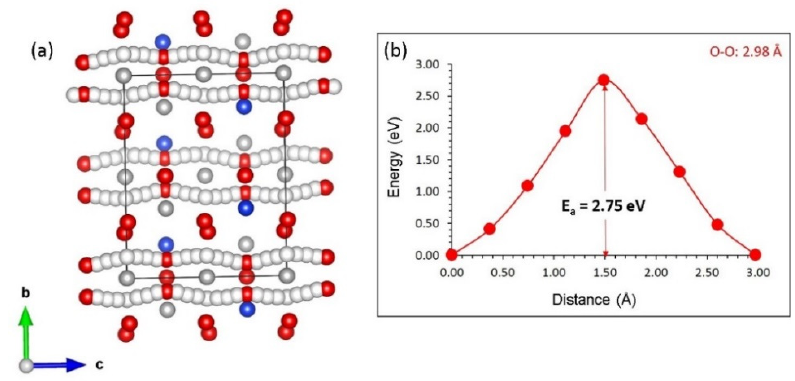
Figure 5. ( a ) Oxygen vacancy local hops connecting a possible long range pathway and ( b ) energy profile diagram for the local oxygen hop.